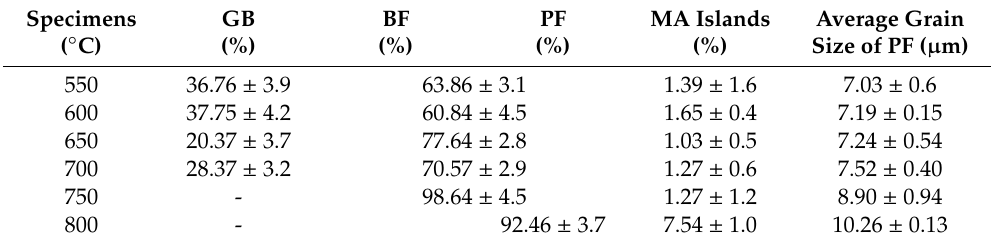
Table 1. The volume fractions of microstructure constituents and PF grain size.